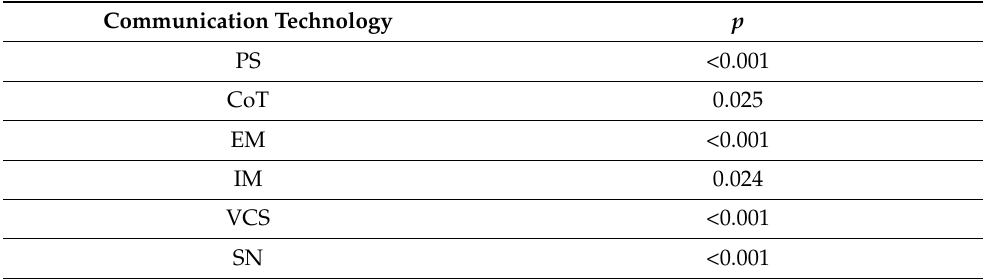
Table 21. Results of statistical inference t-test to verify the independence of the responses of students and teachers to question 10 about the actual usage of communication technologies ( p ≤